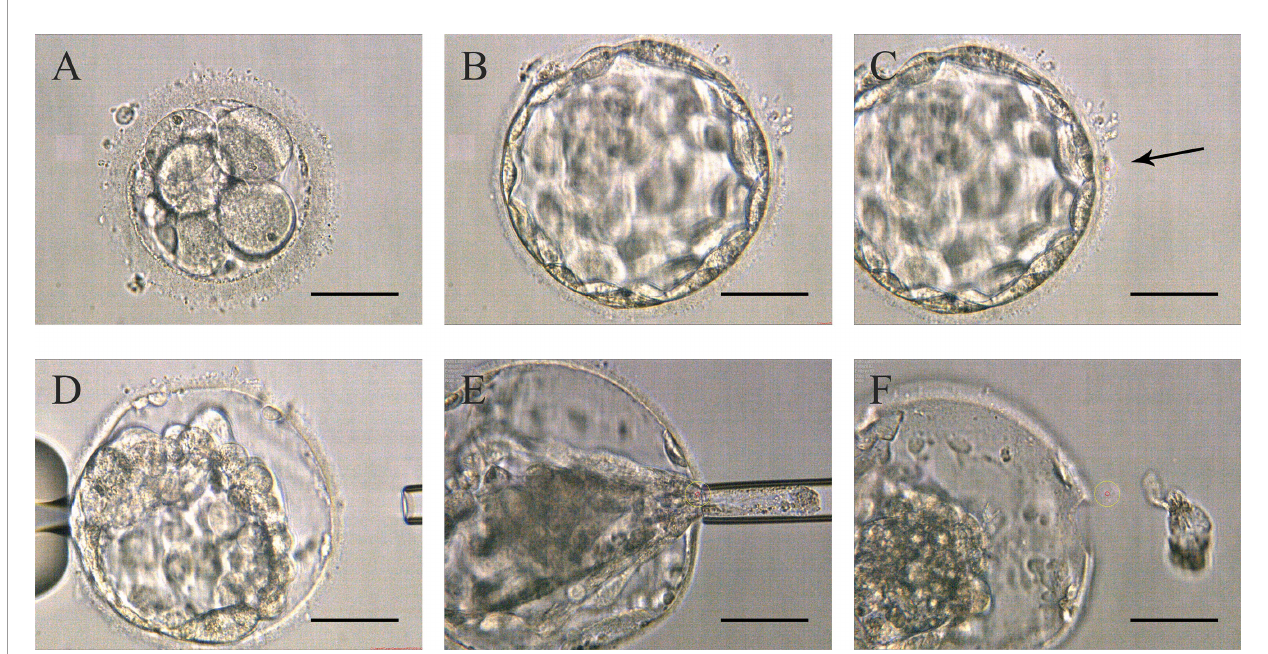
FIGURE 2 | Procedures of Strategy B (A) Embryos on day 3 without zona pellucida opening. (B) High-quality blastocyst with an expansion grade of 4 with AA, AB, BA, or BB on day 5 or 6. (C) The zona pellucida was opened a small hole (pointed by the black arrow in the picture) to fl ow out blastocyst fl uid. (D) After the trophectoderm cells shrunk, the lasers were used to make a hole in the zona pellucida. (E) The biopsy pipette entered the inner blastocyst to suck the cells out of the zona pellucida, and disconnected the junction in front of the biopsy pipette with lasers. (F) Trophectoderm cell samples isolated from the embryo ’ s body. Scale bar = 50